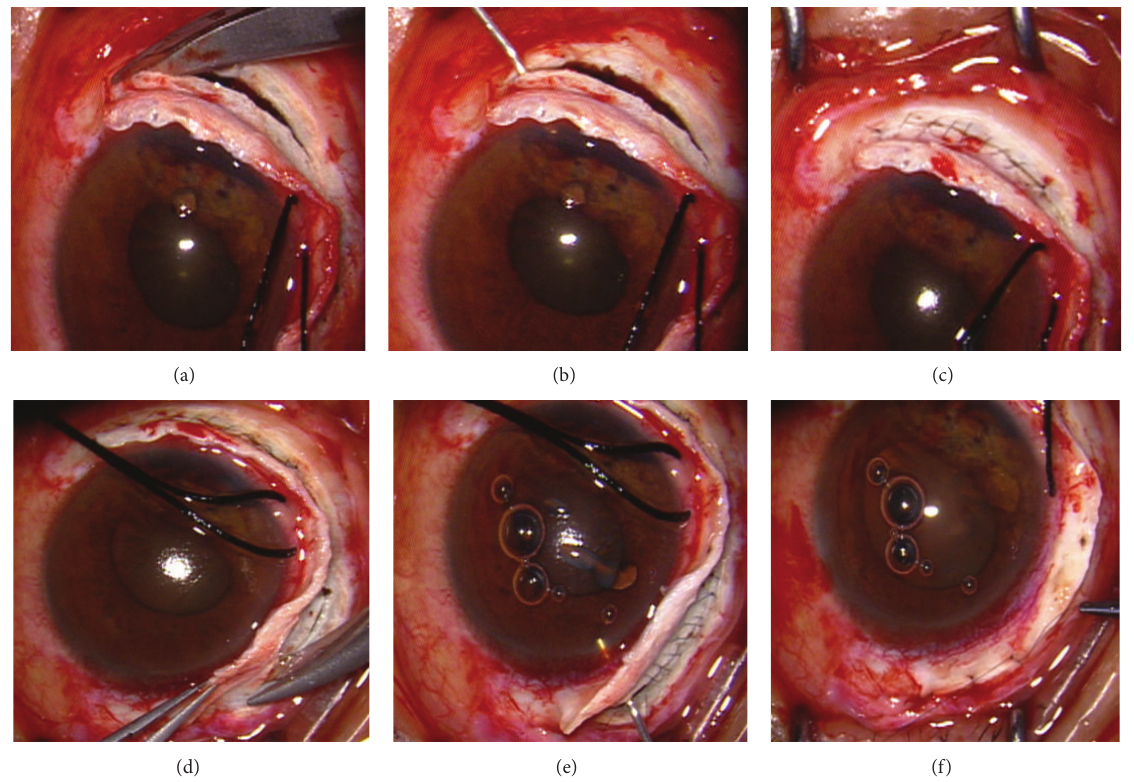
Figure 1: Surgical procedure to close the cyclodialysis cleft (case 3). (a) Beginning with a half deep scleral incision with scissors, we moved from the middle to the inferior end of the cleft behind the limbus, 1.5 mm, following the partial-thickness scleral flap. (b) A blunt probe was inserted into the anterior chamber, which was filled with a viscoelastic agent, and then the end of the cleft was gently detected. (c) Beginning with the first starting stitch from the middle of the cleft, we then extended to the end with a running 10-0 nylon suture. (d) Dissecting the other half of the deep scleral flap over the other half cleft. (e) Again detecting with the probe, we closed the cleft as described previously. (f) Closing the scleral flap and conjunctiva with interrupted sutures, respectively.